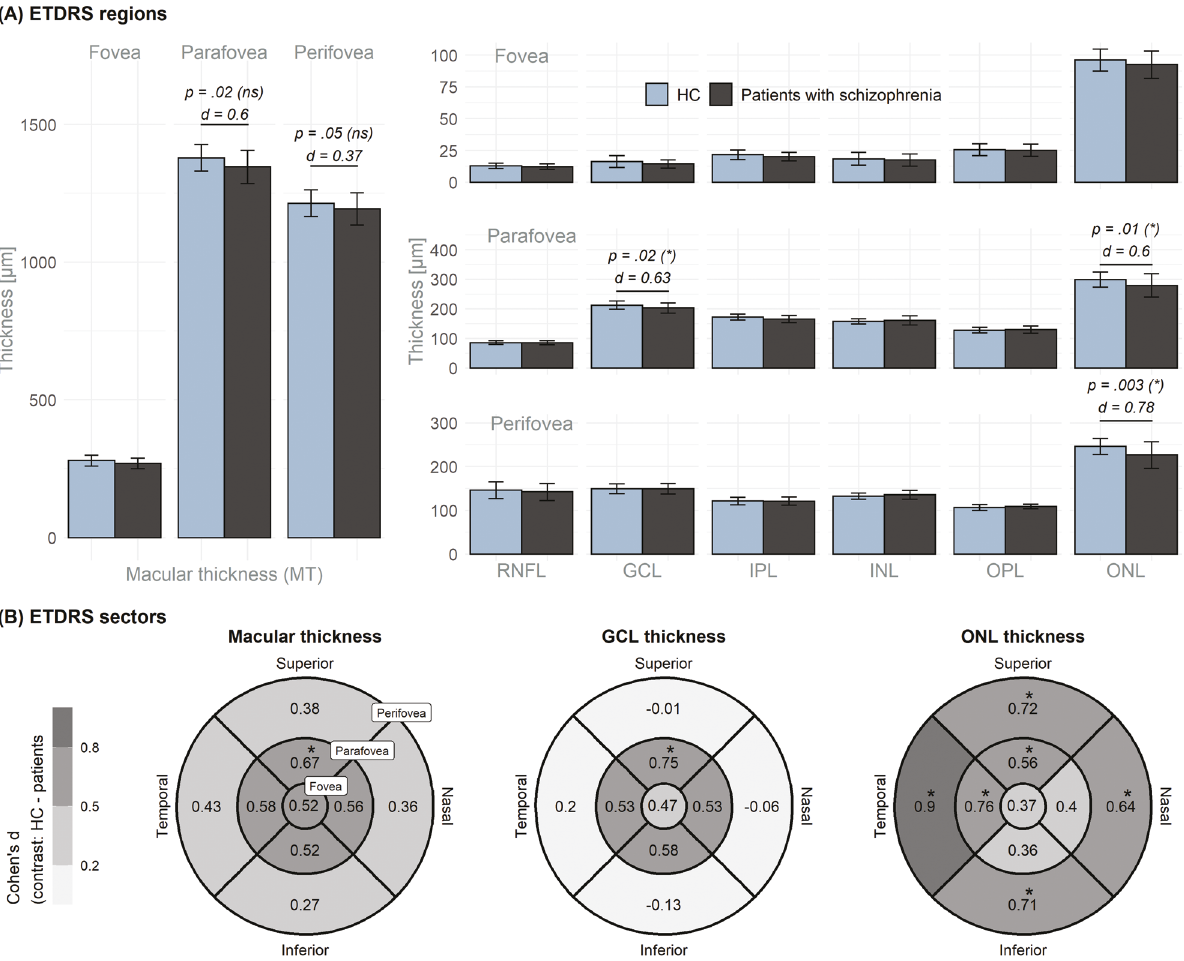
Fig. 3 Circumfoveal layer thickness. A The foveal regions of the ETDRS grid. P -values < 0.05 from tests for the macular, GCL, and ONL thicknesses; Bonferroni – Holm adjusted signi fi cance level in parentheses. B ETDRS sector analysis for the macular, GCL, and ONL thicknesses. Cohen ’ s d ( d ) contrasting HC and patients. Signi fi cant group differences are indicated by the “ * ” . The number of sectors in the para- and perifoveal rings were considered for Bonferroni – Holm adjustment. d Cohen ’ s d, GCL ganglion cell layer, HC healthy controls, INL inner nuclear layer, IPL inner plexifom layer, ns not signi fi cant, ONL outer nuclear layer, OPL outer plexiform layer, RNFL retinal nerve fi ber layer, * signi fi